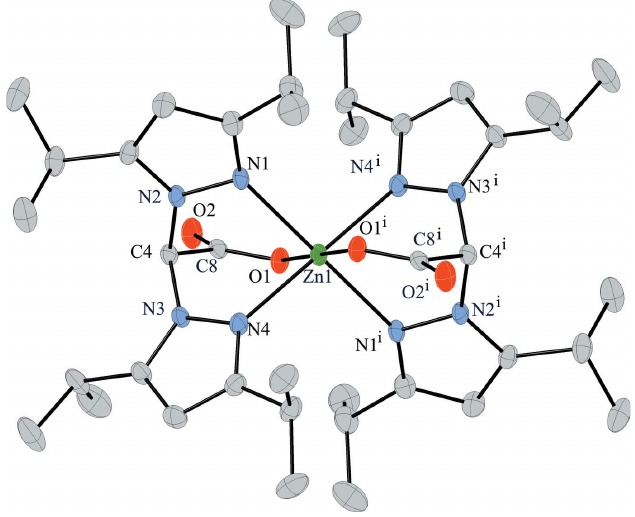
Figure 1 A view of the structure of the title compound, showing the atom-labeling scheme. Displacement ellipsoids are drawn at the 50% probability level. Symmetry code for generating equivalent atoms: (i) (cid:2) x , (cid:2) y , (cid:2) z +